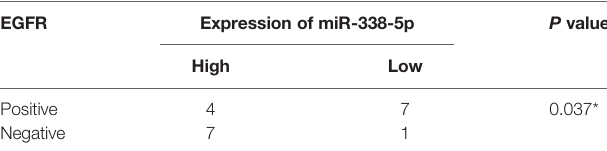
TABLE 2 | Association between the expression of miR-338-5p and EGFR in PC cases (N = 19).